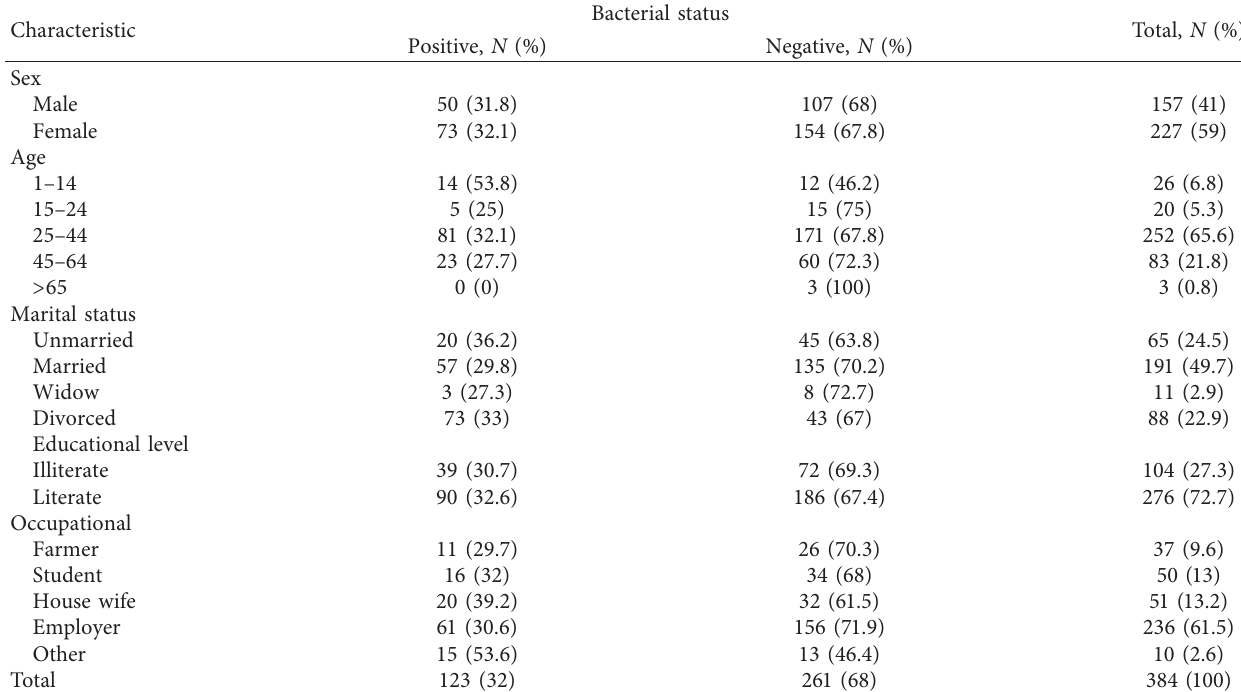
Table 1: Demographical characteristics of study participants with bacterial bloodstream infection among HIV/AIDS patients in Felege Hiwot Referral